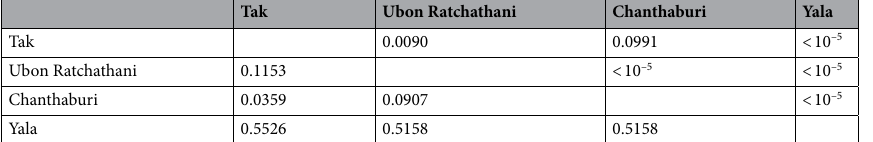
Table 6. Genetic differentiation of P. falciparum populations inferred from PfGARP. F ST indices and their respective p values are in lower and upper diagonals,